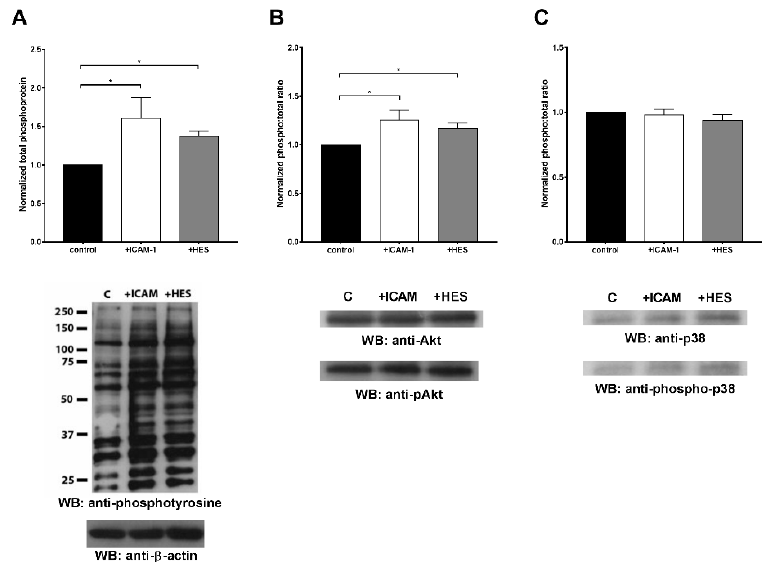
Figure 7. Evaluation of integrin activation by HES. ( A ) HES-mediated outside-in integrin activation was evaluated by determining total phosphorylation of tyrosine on intracellular proteins through Western blot (only a representative blot is showed in the picture). HES caused a significant increase in total phosphorylation compared to the control. ( B ) Evaluation of Akt activation by Western blot. HES treatment significantly increased the phosphorylation of Akt the activation of this pathway. ( C ) Evaluation of p38 activation by Western blot. As reported, neither HES nor ICAM caused the activation of the p38/MAPK pathway. In the blots, lane C represents the control. The presented results are the mean ± SD of three independent experiments. * p < 0.05 .